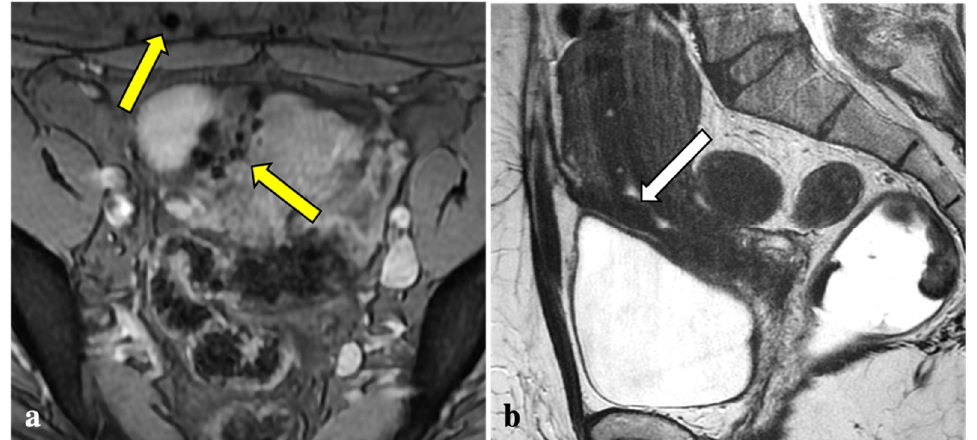
Figure 3. T2* ‐ weighted imaging pitfall. An oval signal void (yellow arrow) localized in the right ovary was detected on T2* ‐ weighted imaging in a 23 ‐ year ‐ old patient ( a ). This lesion corresponded to a thick ‐ walled haemorrhagic corpus luteal cyst (white arrow) with an internal high signal on T1W ( b ), consistent with blood content.